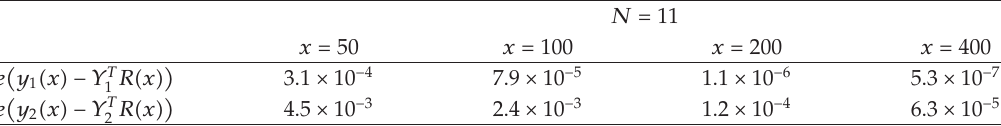
Figure 2: Graph of the exact and numerical solutions of y 2 (cid:6) x (cid:4) for N (cid:9) 13; symbols correspond to the numerical solution. Table 2: Absolute error for large values of x